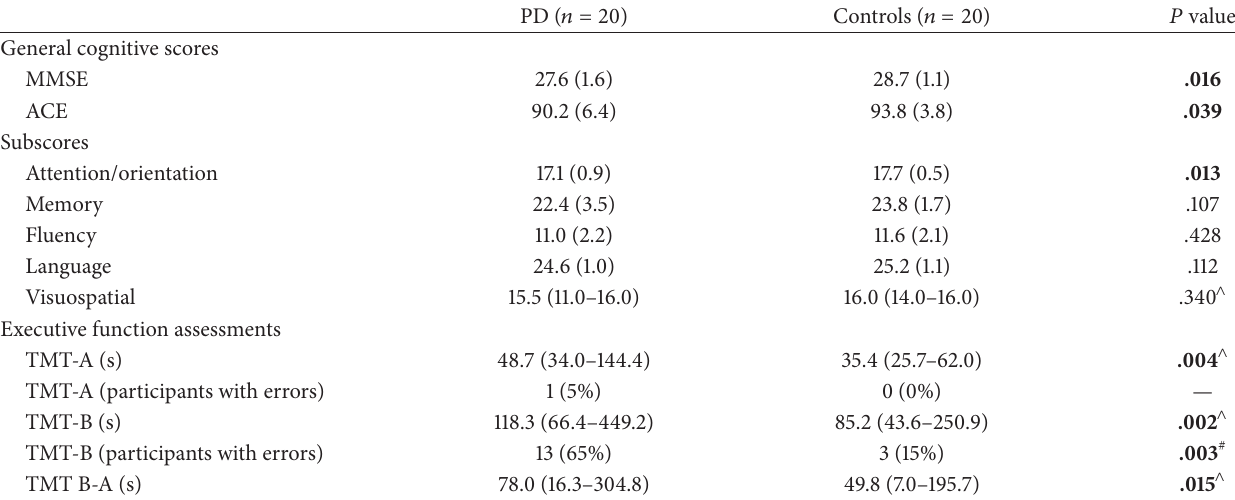
Table 3: General cognitive and executive function for the PD and control groups.